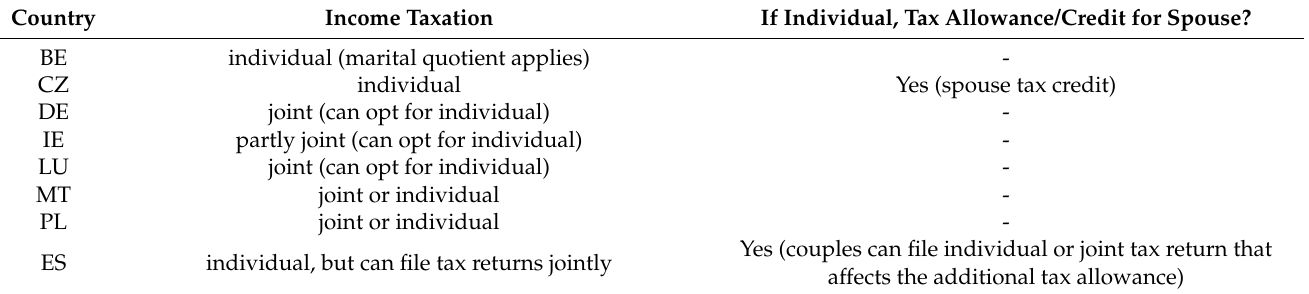
Table 1. Tax treatment of married couples across